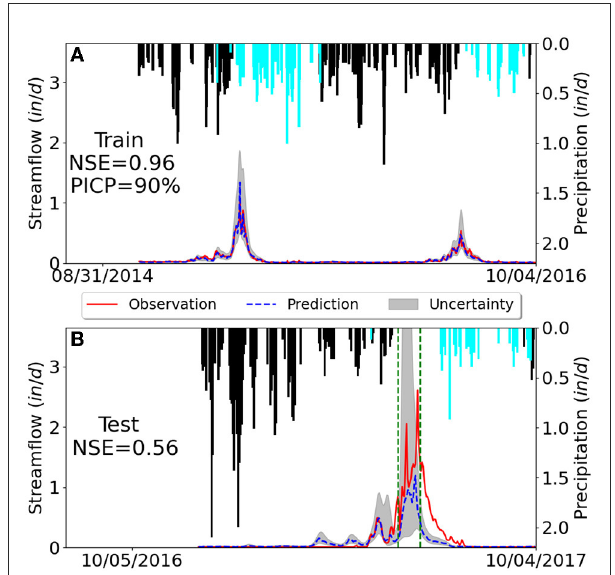
FIGURE4 Predicted (dashed blue line) and observed streamflow (solid red line) in the snow-dominant Rock creek catchment where the gray area quantifies the predictive uncertainty. Corresponding daily precipitation is plotted upside down where snow (temperature below 0 ◦ C) is highlighted in black. Subfigures (A, B) illustrate the results from training and test data sets, respectively.